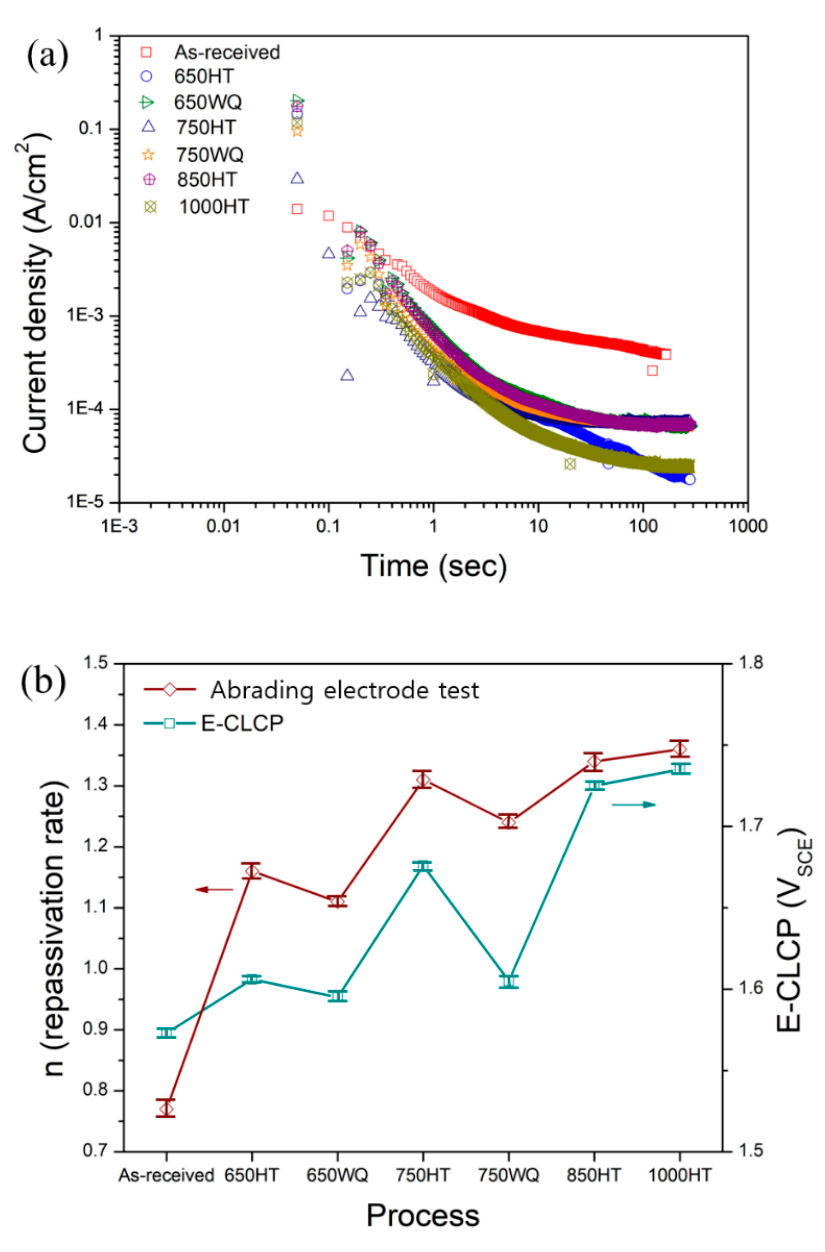
Figure 16. Plots of i ( t ) vs. time in logarithmic scale for ( a ) all AM Ti–6Al–4V alloys and ( b ) the comparison between the repassivation rate obtained from the abrading electrode technique and E-CLCP (HT: furnace cooling; WQ: water quenching).